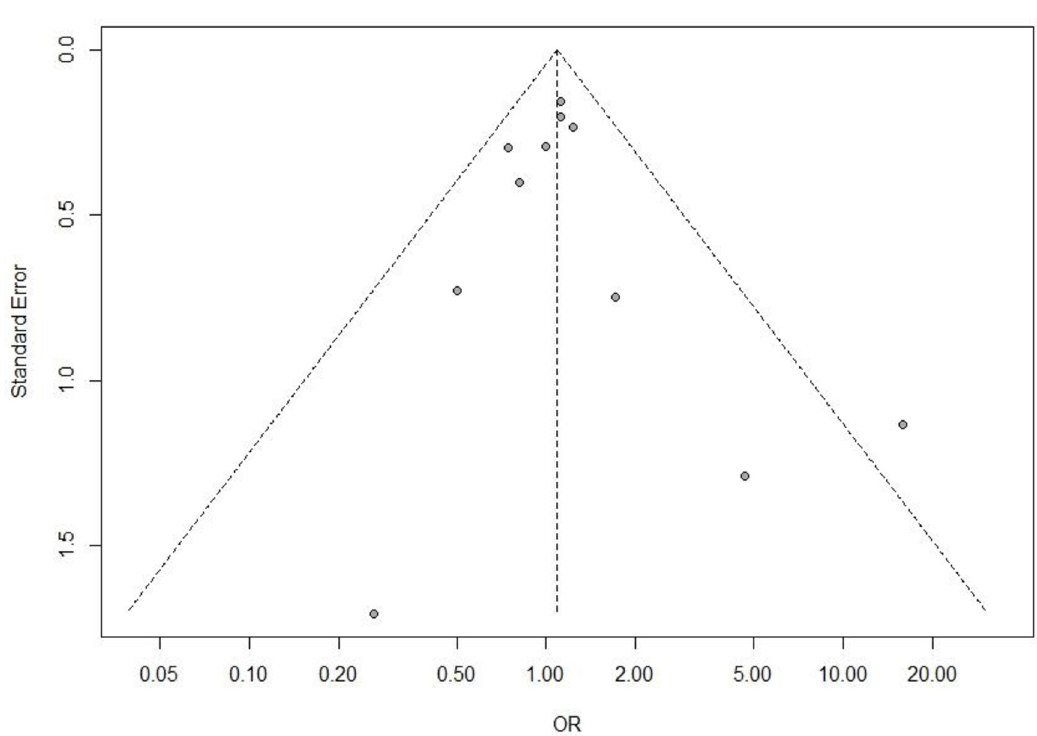
Fig 9. Funnel plot, using data from 11 trials of novel glycopeptides therapy in patients with gram positive cocci.